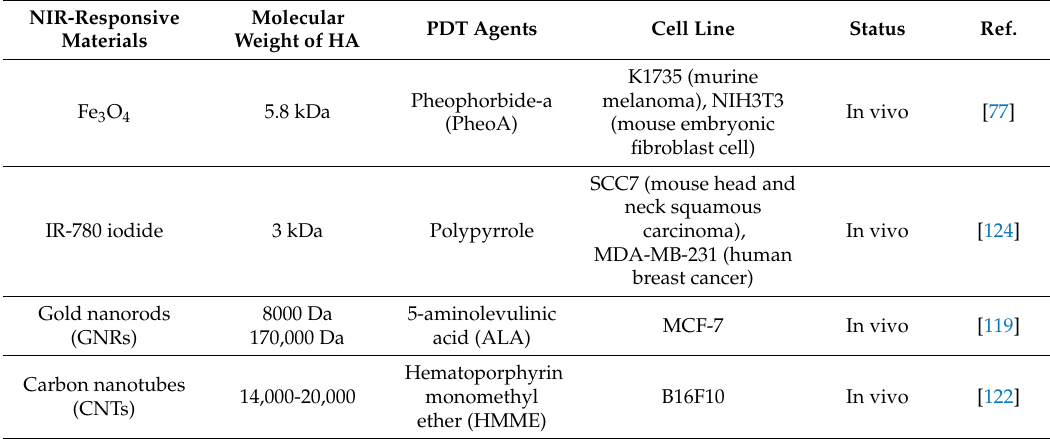
Table 3. HA-modified nanoplatforms for combined photothermal photodynamic therapy